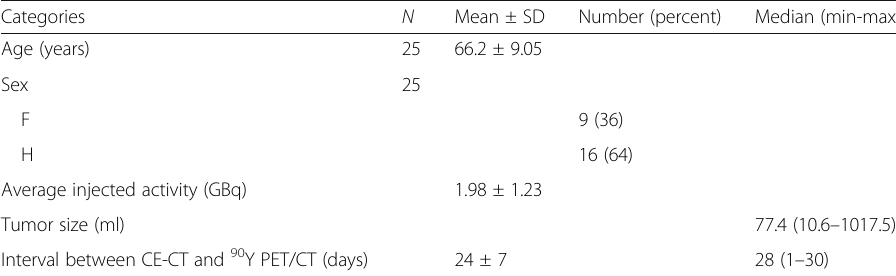
Table 1 Summary of patients characteristics